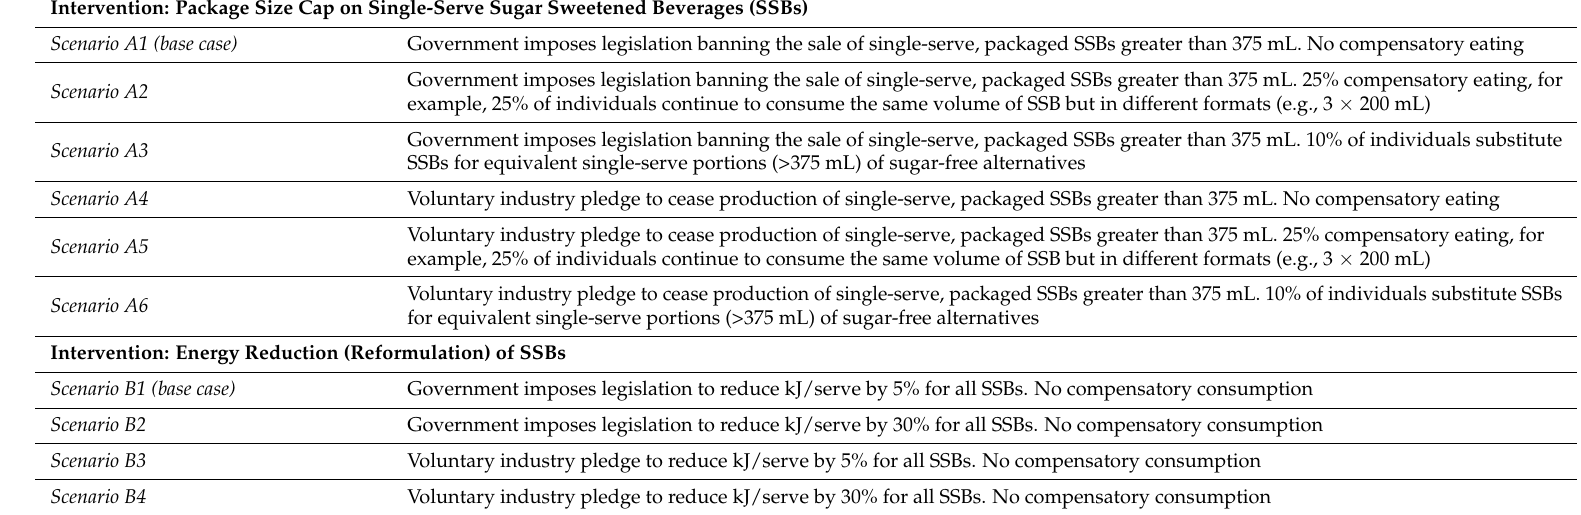
Table 1. Scenarios